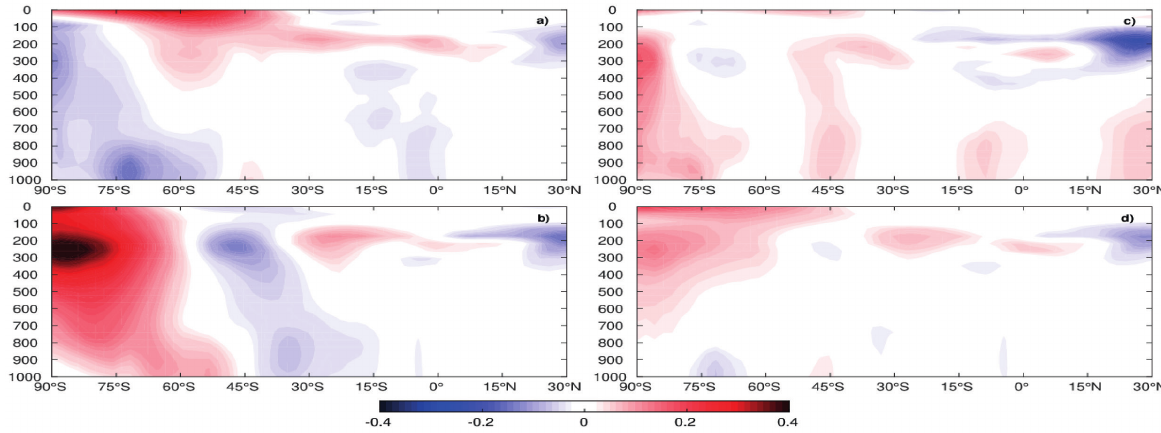
Figure 4. Differences between the layermax-layerctl experiments for the meridional mean (from 90°S to 30°N) wind profile (ms -1 ) for the Atlantic sector (from 65°W to 15°E) during the periods: a) July 2020–June 2024; b)